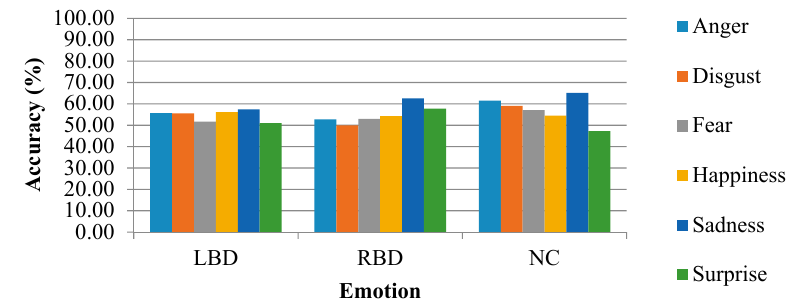
Figure 15. The accuracy of each emotional state using the PNN classifier.